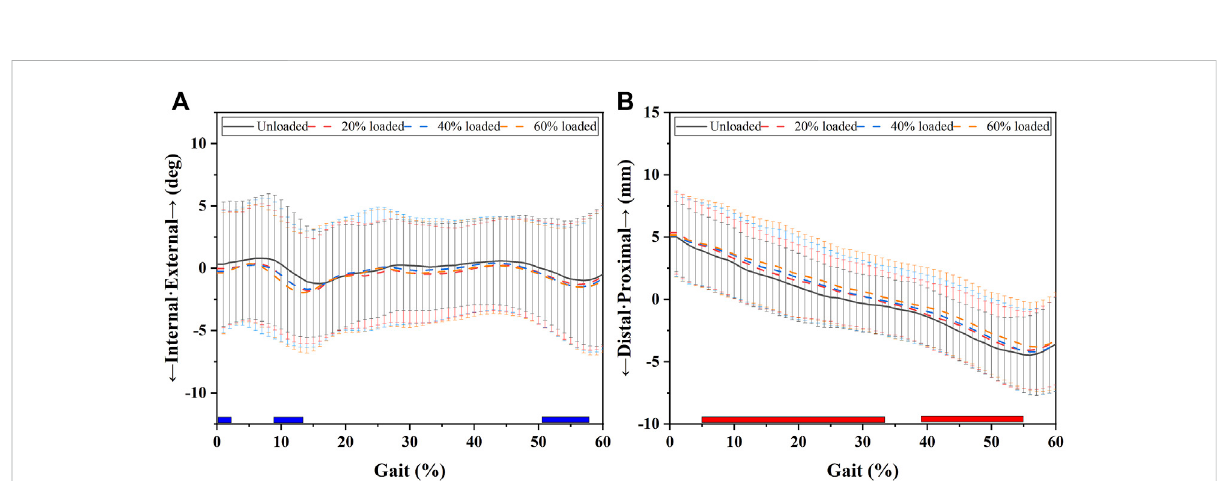
FIGURE 3 Transverse knee kinematic alterations during the stance phase with increased load levels. Chart (A) shows the internal (-)/external (+) tibial rotationalterationsthatoccurredduringthestancephase.Chart (B) showsthedistal(-)/proximal(+)tibialtranslationalterationsthatoccurredduring the stance phase. The blue bars in Chart (A) show the phases in which increased load levels signi fi cantly increased internal tibial rotation angle or distaltibialtranslation.TheredbarsinChart (B) showthephasesinwhichincreasedloadlevelssigni fi cantly increasedtheexternaltibialrotation angle or proximal tibial